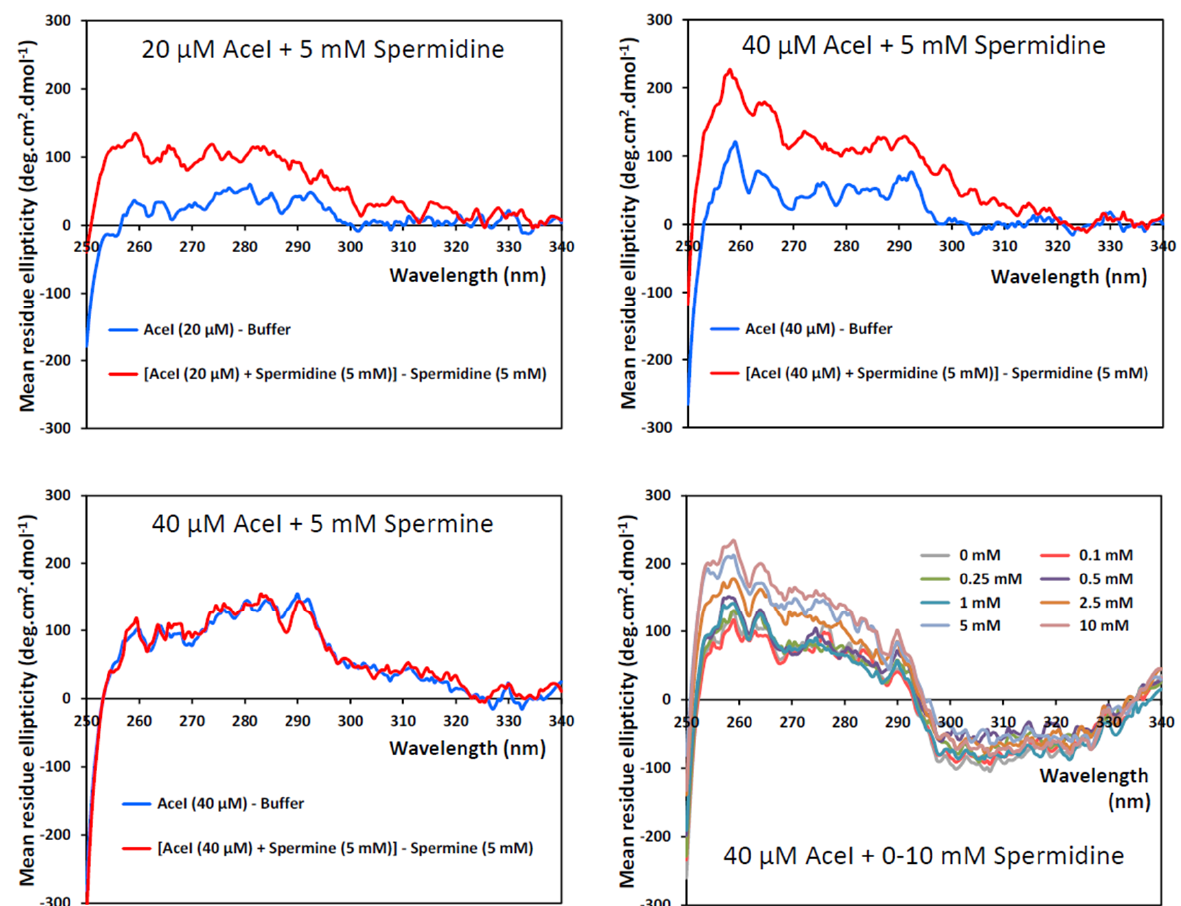
Figure 1. Spermidine binding to the A. baumannii efflux protein AceI observed by near-UV syn- chrotron radiation circular dichroism spectroscopy. Near-UV SRCD spectra (250–340 nm) at 20 °C for samples of DDM-solubilised AceI(His 6 ) (20 μM or 40 μM in 10 mM KPi pH 7.6, 5% glycerol, 0.05% DDM) showing the effect of spermidine (5 mM) ( top ) or spermine (5 mM) ( bottom left ) and a titration with spermidine (0–10 mM) ( bottom right ). All spectra are an average of 10 scans acquired over approximately 1 h. Spectra were corrected for any signals coming from buffer or from the polyamines themselves by subtraction of the relevant spectra acquired on these sample components alone, as appropriate.